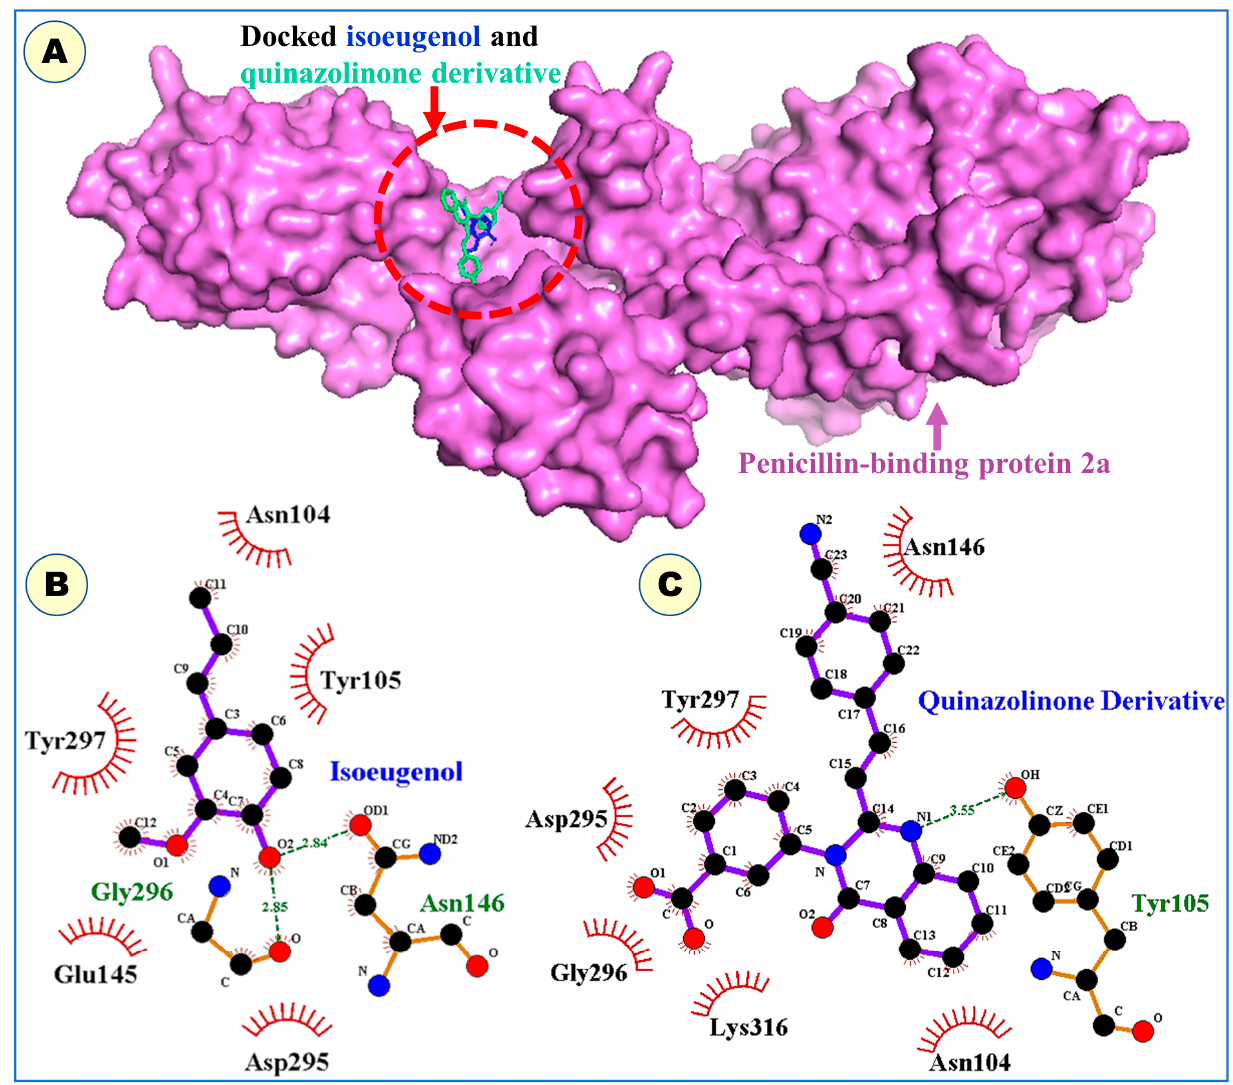
Figure 1. ( A ) Docking predicted molecular conformations of isoeugenol (shown as sticks in blue color) and quinazolinone antibiotic (depicted as sticks in cyan color) in the allosteric site of penicillin-binding protein 2a (shown as surface in magenta color). ( B ) Ligplot diagram of the docked isoeugenol showing binding residues. ( C ) Intermolecular interactions of quinazolinone antibiotic are shown by ligplot diagram.